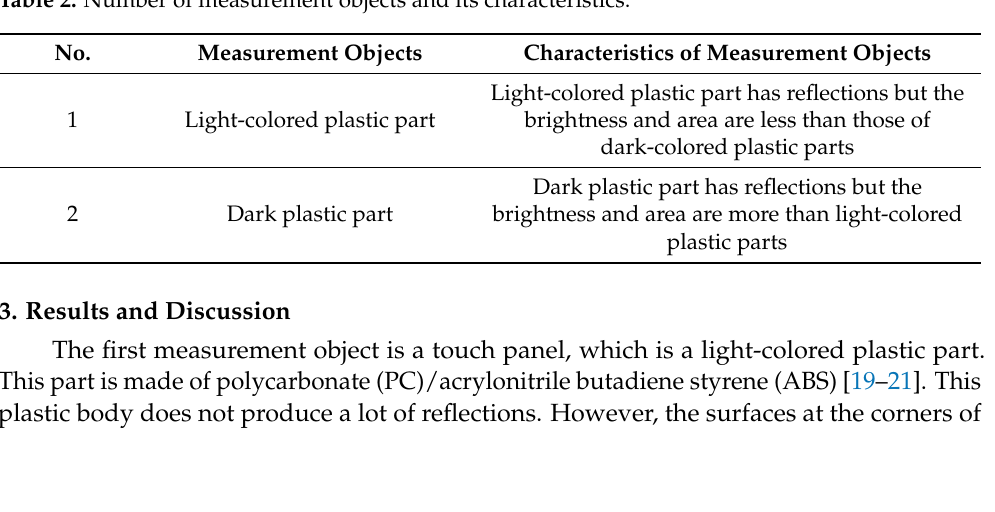
Table 2. Number of measurement objects and its